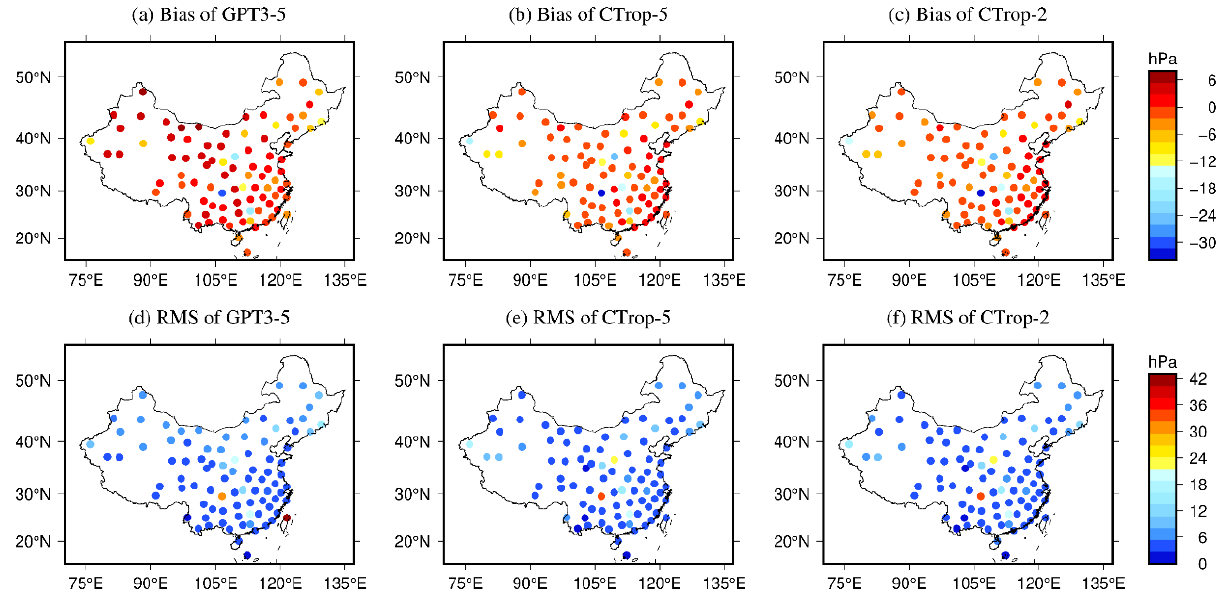
Figure 11. Distribution of the performance of water vapor pressure in different resolutions of the CTrop and GPT3 models validated by radiosonde sites in 2017: ( a ) Bias of GPT3-5; ( b ) Bias of CTrop-5; ( c ) Bias of CTrop-2; ( d ) RMS of GPT3-5; ( e ) RMS of CTrop-5; ( f ) RMS of CTrop-2. The positive bias means the model outputs are larger than the reference values, while the negative bias means they are smaller than the reference values.